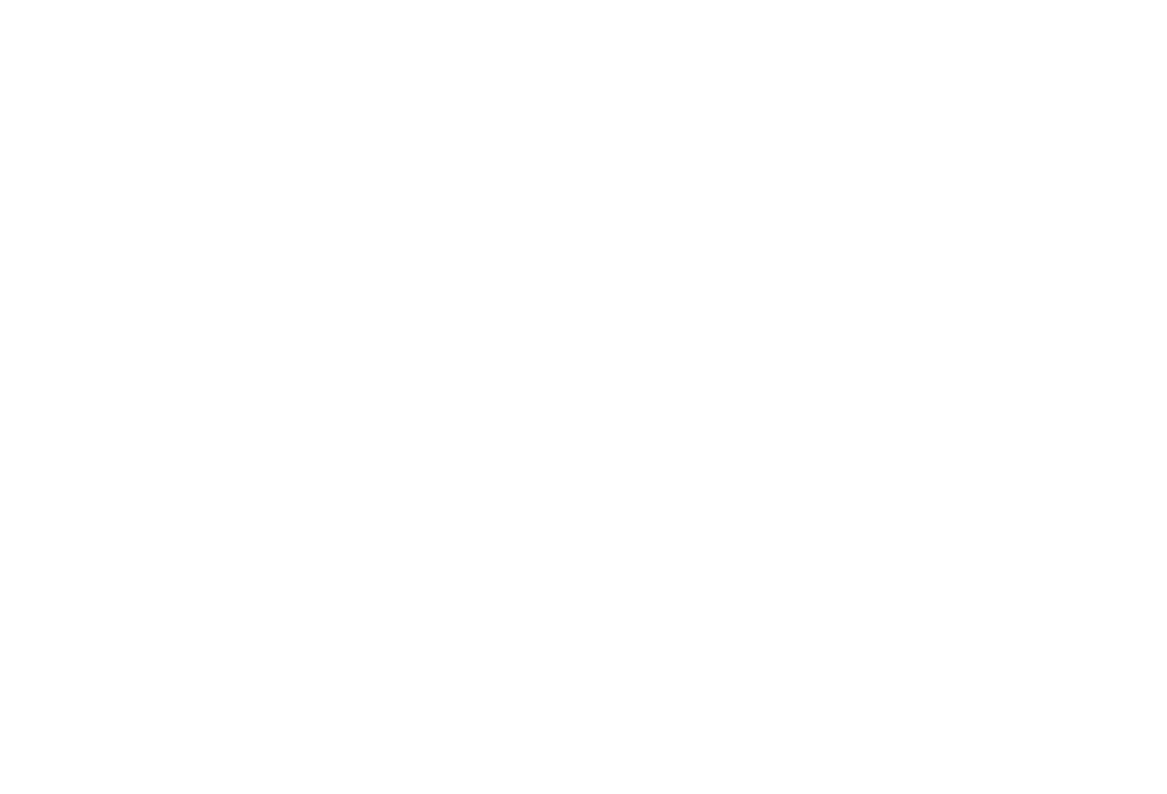
Figure 10. Some examples of tea leaf disease detection results using YOLOv7. The bounding boxes consist the images of diseased tea